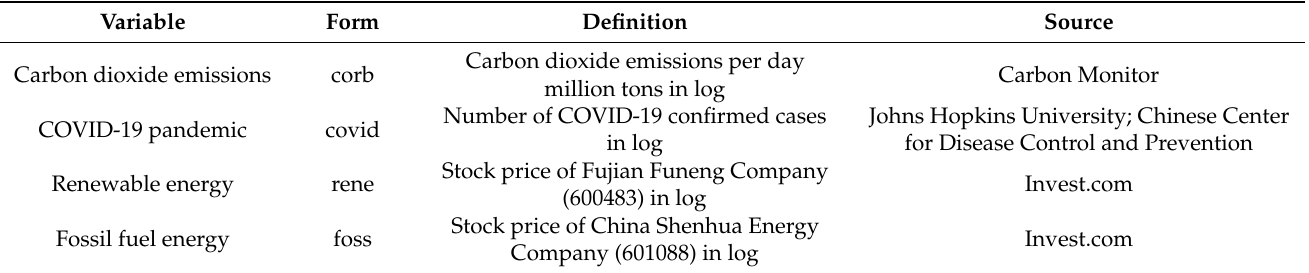
Table 1. Results of variable